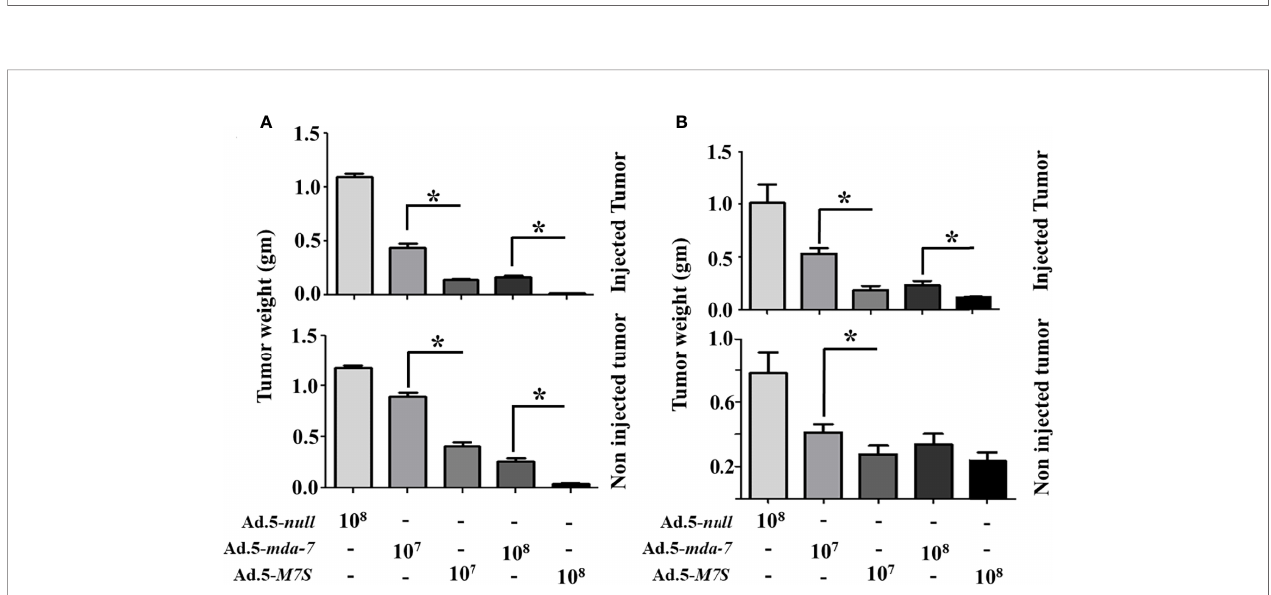
sacri fi ced on day 21 after the fi rst viral injections. Tumor weight was measured. Data presented as the average weight at day 14 from 5 mice from each group. (B) Like panel (A) , DU-145 cells (prostate cancer cell line) were implanted in nude mice and infected with the indicated control virus (Ad.5- null ) and therapeutic viruses (Ad.5- mda- 7 or Ad.5- M7S ). Mice were sacri fi ced on day 21 after the fi rst viral injections. Average tumor weight after 6 injections is presented. In both (A, B) , the “ upper ” and “ lower ” panels represent tumors with virus or without virus treatment, respectively. Error bars are S.D. from fi ve mice. *Statistical signi fi cance (p <